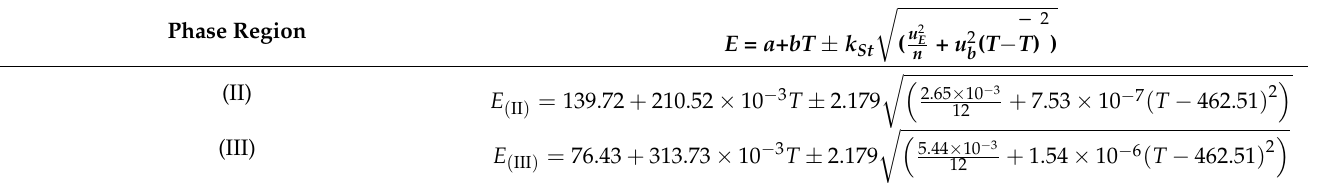
Table 2. EMF vs. temperature relations for the type (A) ECCs in the (II) and (III) phase regions of the Fe–Ag–Ge–Te system, in the temperature range between 435 and 490 K. The coefficients a and b were obtained through the linear least squares analysis of the EMF vs. T measuremnt data, n is the number of experimental points, k St is Student’s coefficient with the level of confidence